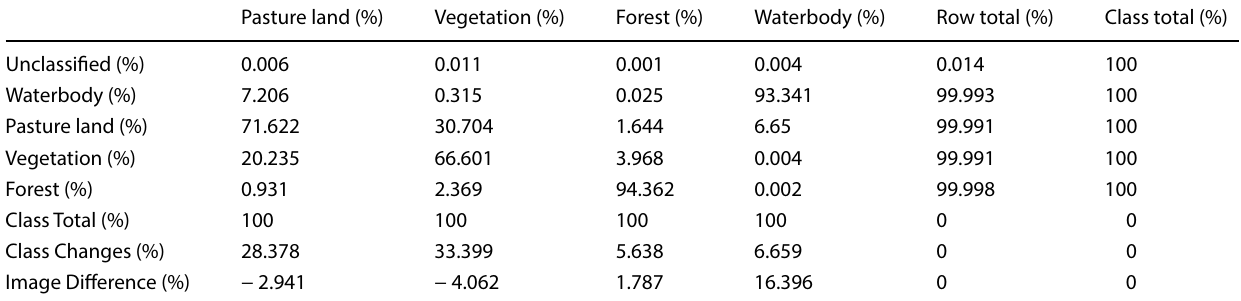
Table 6 Change detection statistics 2007